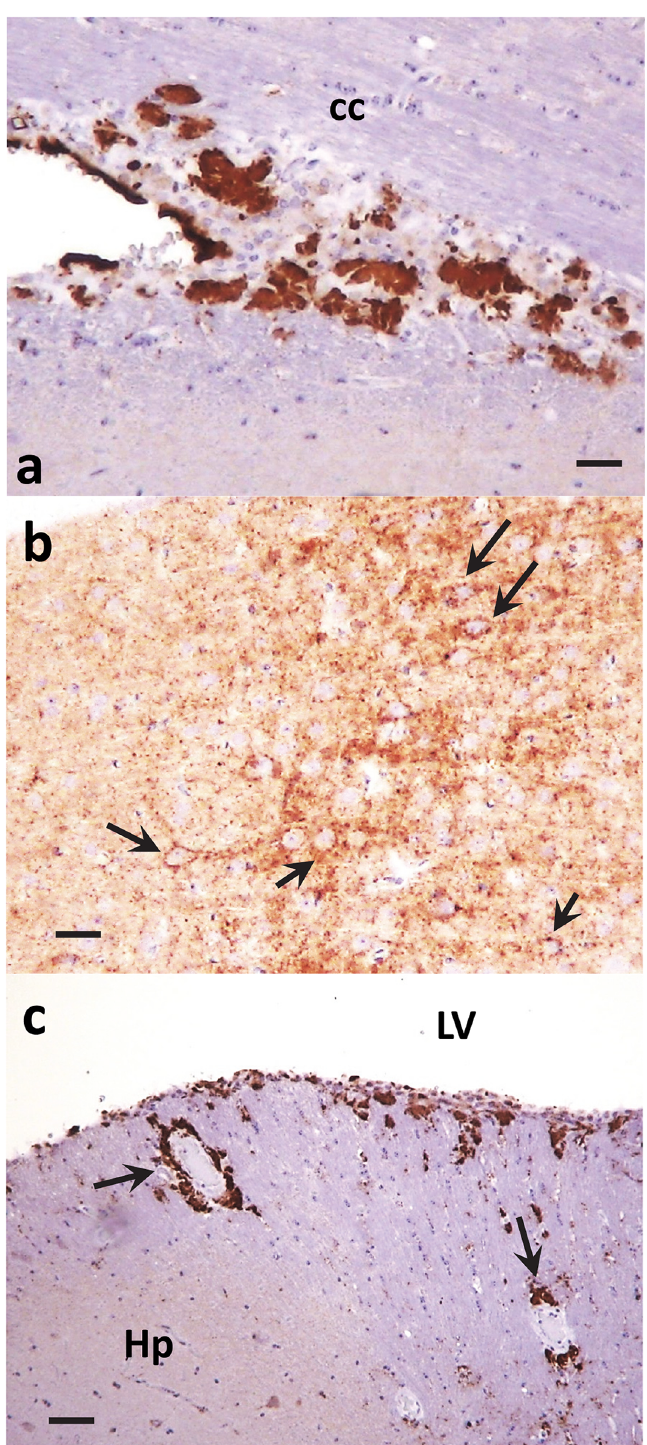
Fig 5. Histopathological analysis of brains from the 2 nd passage of PrPres produced in dgPMCAb reactions seeded with fibrillar WT α -synuclein. Subcallosal( a ), perineuronal ( b , indicatedby arrows) and perivascular ( c , indicatedby arrows) PrP immunoreactivity as stained with anti-PrP 3F4 antibody.Ctx, cortex; cc, corpus callosum; Hp, hippocampus; LV, lateral ventricle. Scale bars: in a, c = 100 μ m, b = 50 μ m.